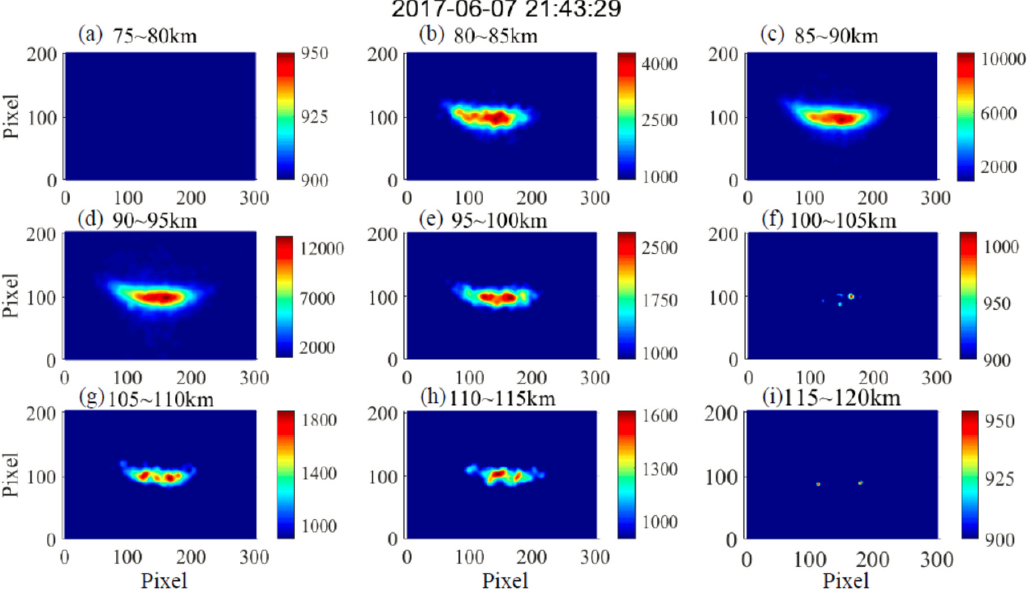
Figure 8. Layout of the Na layer images at six altitude ranges (every 5 km): 75–80 km (a), 80–85 km